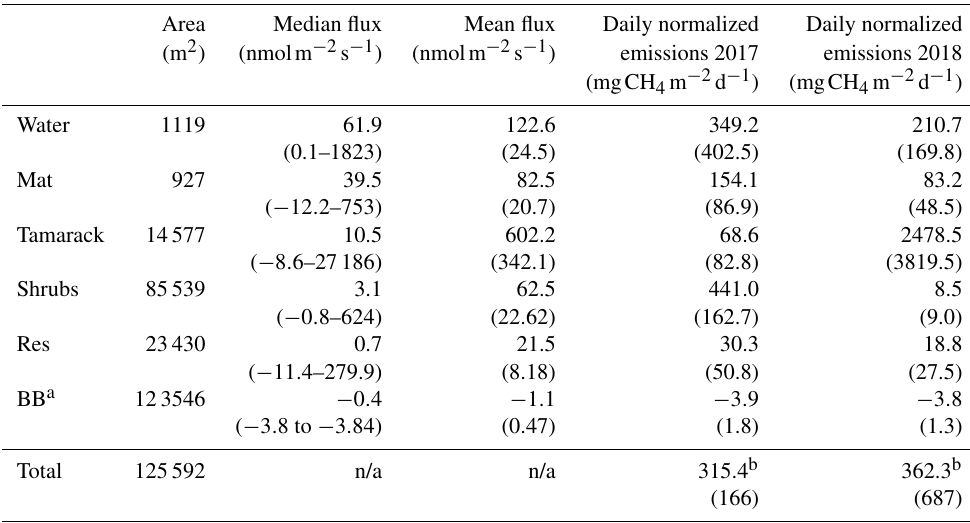
Figure 2. Water-level (WL) fluctuations in the tamarack mixed woodland (Tam) zone, the mixed ericaceous shrub (Shrubs) zone, and the restored (Res) zone of the bog. Vertical dashed lines indicated the 10 times of pore-water sampling, and the solid lines indicate the two times of core sampling: gray for Tam, Shrubs, and Res-S and teal for Mat and Res-N. The secondary axis shows daily values of precipitation. Table 1. CH 4 fluxes for the different hydro-biological zones in Flatiron Lake Bog. Integrated fluxes are based on a 122d period for 2017 and 149d period for 2018. Values in parenthesis for mean fluxes are the standard error and for the subsequent rows the propagated standard